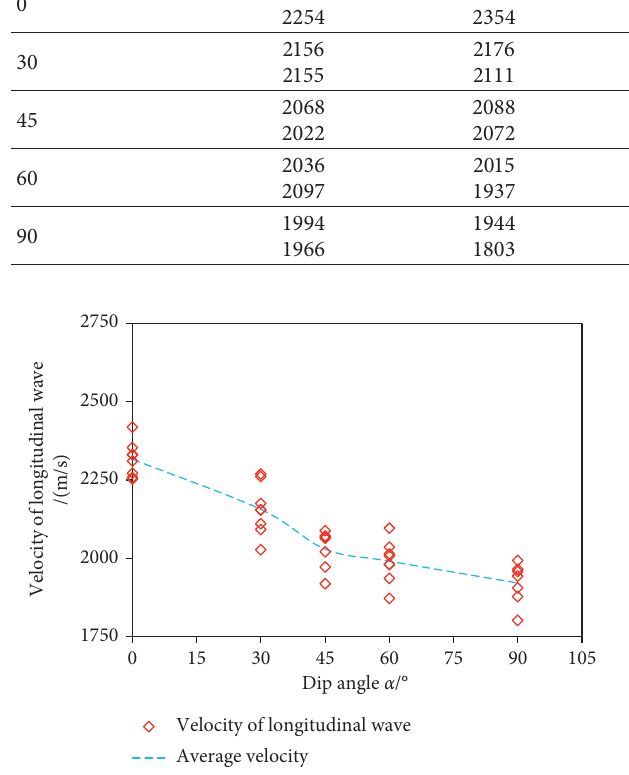
Figure 5: Longitudinal wave velocity of tight sandstone samples with different dip